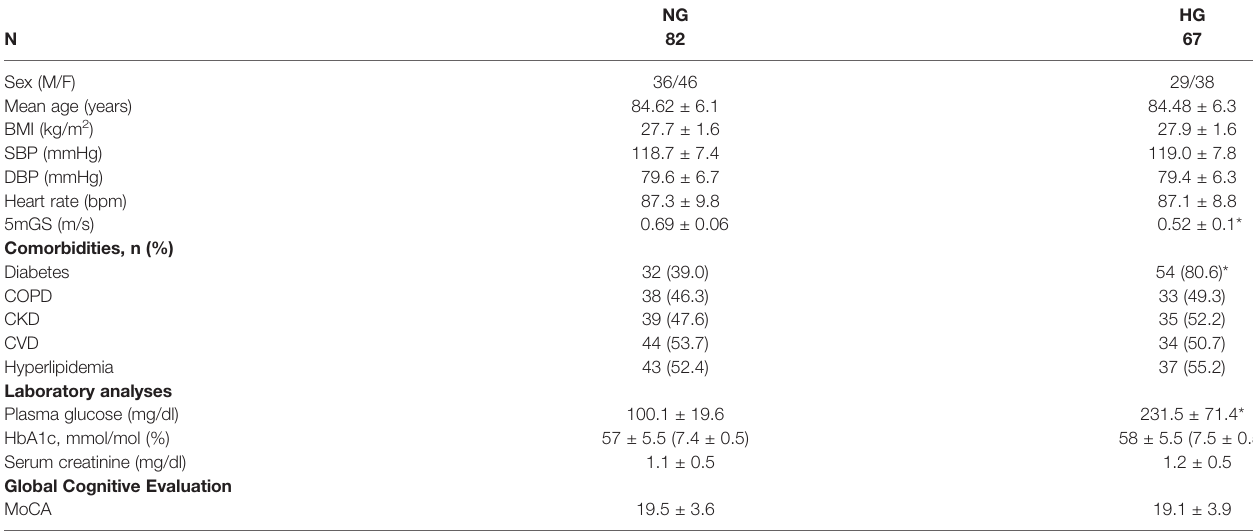
TABLE 1 | Clinical characteristics of the patients.